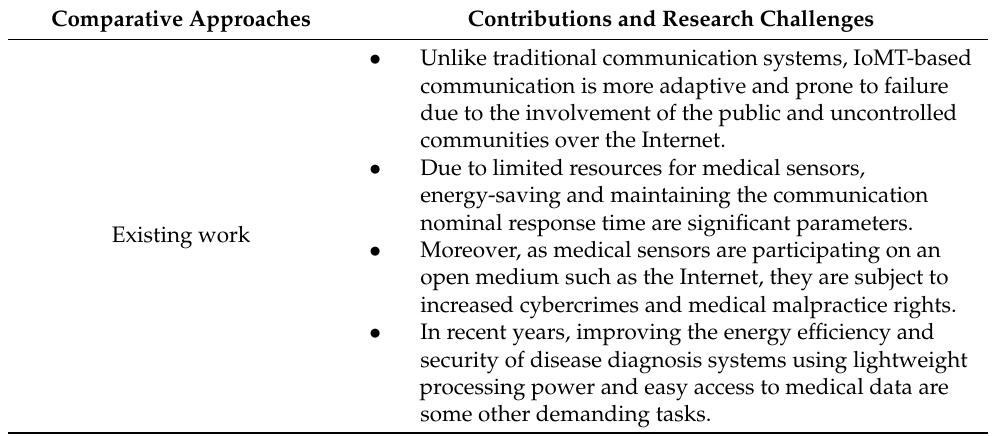
Table 1. Summary of related